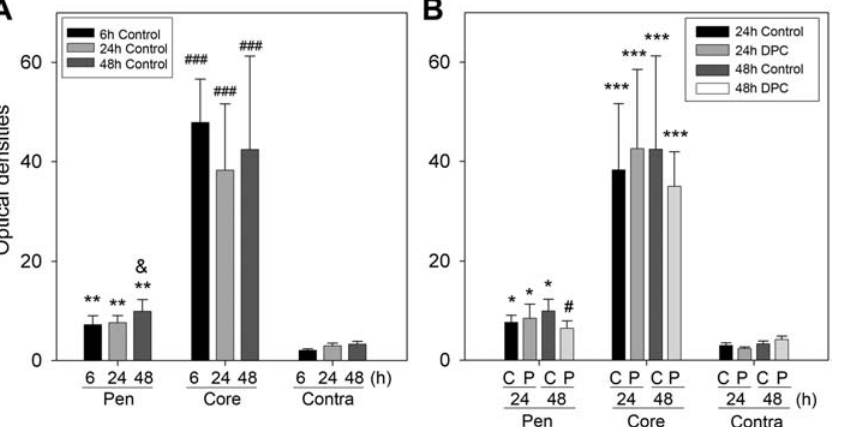
Figure 8. Delayed postconditioning (DPC) inhibited BBB leakage. The ischemic core and penumbra and the non-ischemic hemisphere were dissected for Evan’s blue detection. A. Time course of BBB leakage after stroke. The amount of Evan’s blue in the ischemic and non-ischemic hemisphere was detected at 6, 24, and 48 h after stroke. Evan’s blue penetrated into the ischemic brain tissue as early as 6 h, and persisted up to 48 h. More leakage occurred in the core than in the penumbra. Pen, penumbra; contra, contralateral hemisphere. ** vs. corresponding contralateral hemisphere, P , 0.01; ### vs. corresponding penumbra and contralateral hemisphere, P , 0.001; & vs. 6 h and 24 h in the penumbra, P , 0.05 (Rank sum test). B. The effect of DPC on BBB was detected at 24 h and 48 h after stroke . DPC reduced BBB leakage at 48 h but not at 24 h after stroke in the penumbra; it had no effect on BBB leakage in the ischemic core. N=5–6/group. C, control ischemia; P, delayed postconditioning. * vs. corresponding contralateral hemisphere, P , 0.05; *** vs. corresponding contralateral hemisphere or penumbra, P , 0.001. # vs. 48 h-control penumbra, P , 0.05.